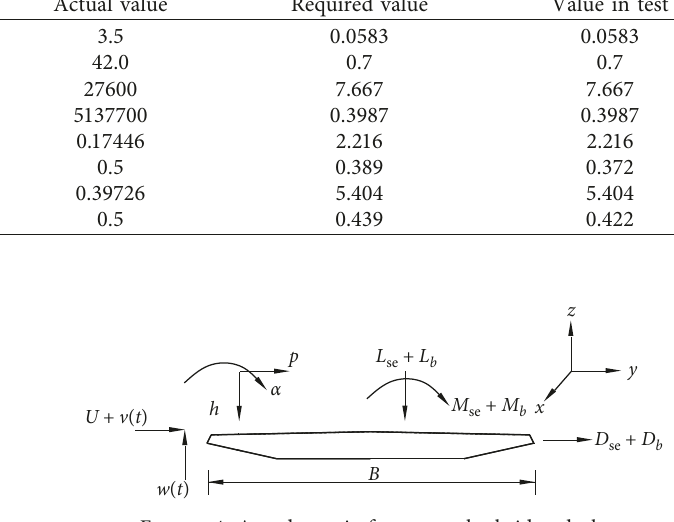
Figure 4: Aerodynamic forces on the bridge